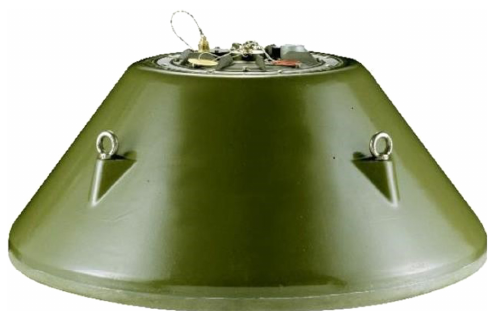
Figure 1. A manta mine